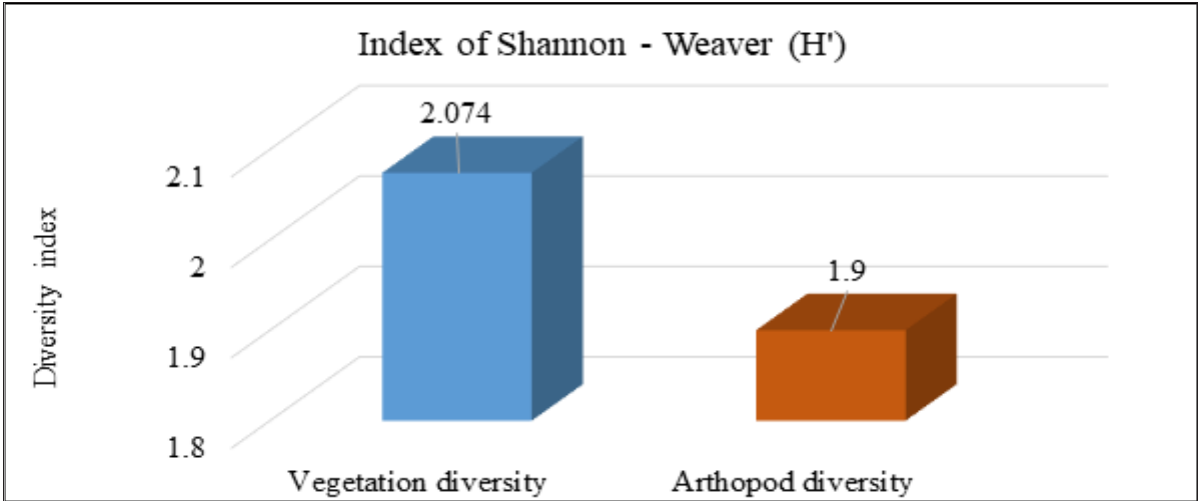
Figure 2: Shannon–Weaver index in vegetation and anthropods soil in Amazonian fruit producing plots in Iquitos – Nauta highway in